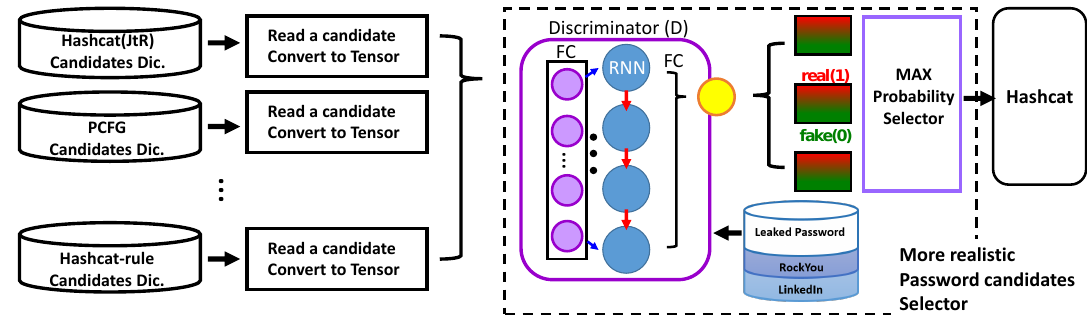
Figure 3. REDPACK Selecting Phase